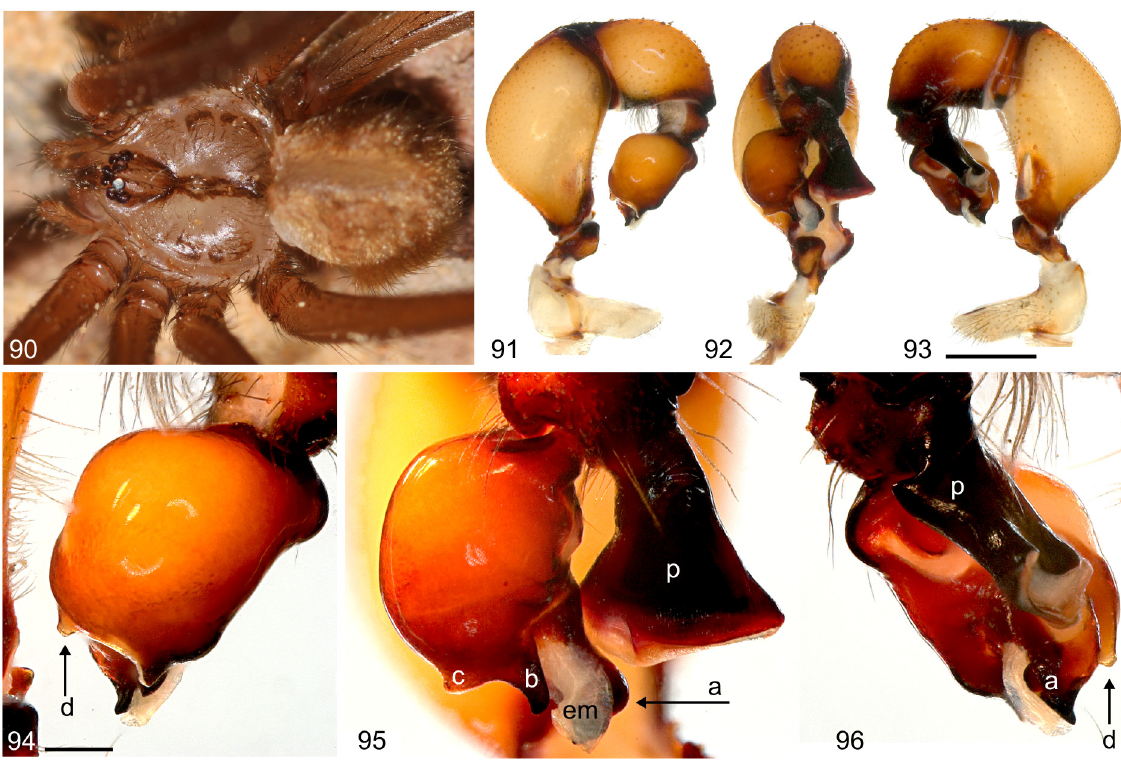
Figs 90–96. Artema doriae Thorell, 1881. 90 . Female, habitus (HUJ Ara 16033, Israel, Memorial Ha- Biq’a, NE Peza’el). 91–93 . Male left pedipalp (ZFMK Ar 15233, Iran, Tehran): prolateral, dorsal, and retrolateral views. 94–96 . Male left bulb and procursus (same specimen): prolateral, dorsal, and retrolateral views. Scale lines: 91–93 = 1 mm; 94–96 =